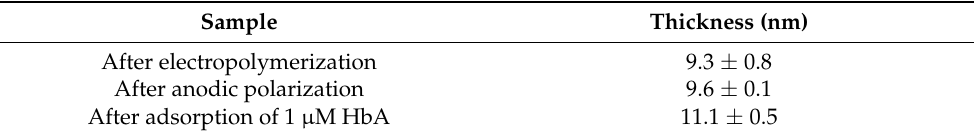
Table 2. Average thickness of the non-imprinted polymer film determined by atomic force mi- croscopy.